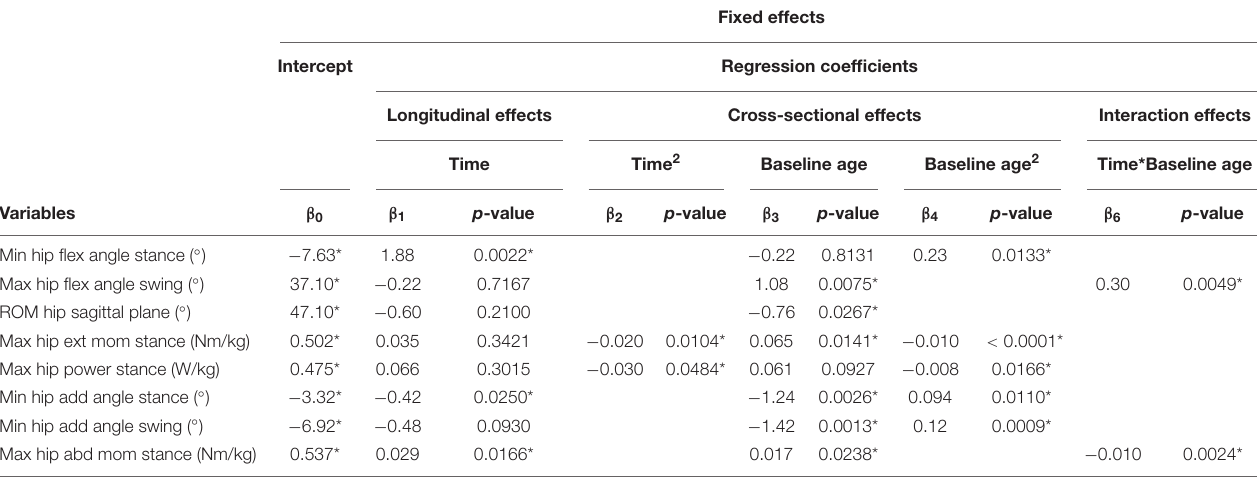
TABLE 5 | Results of linear mixed effect models with the hip kinematics and kinetics as responses in children with